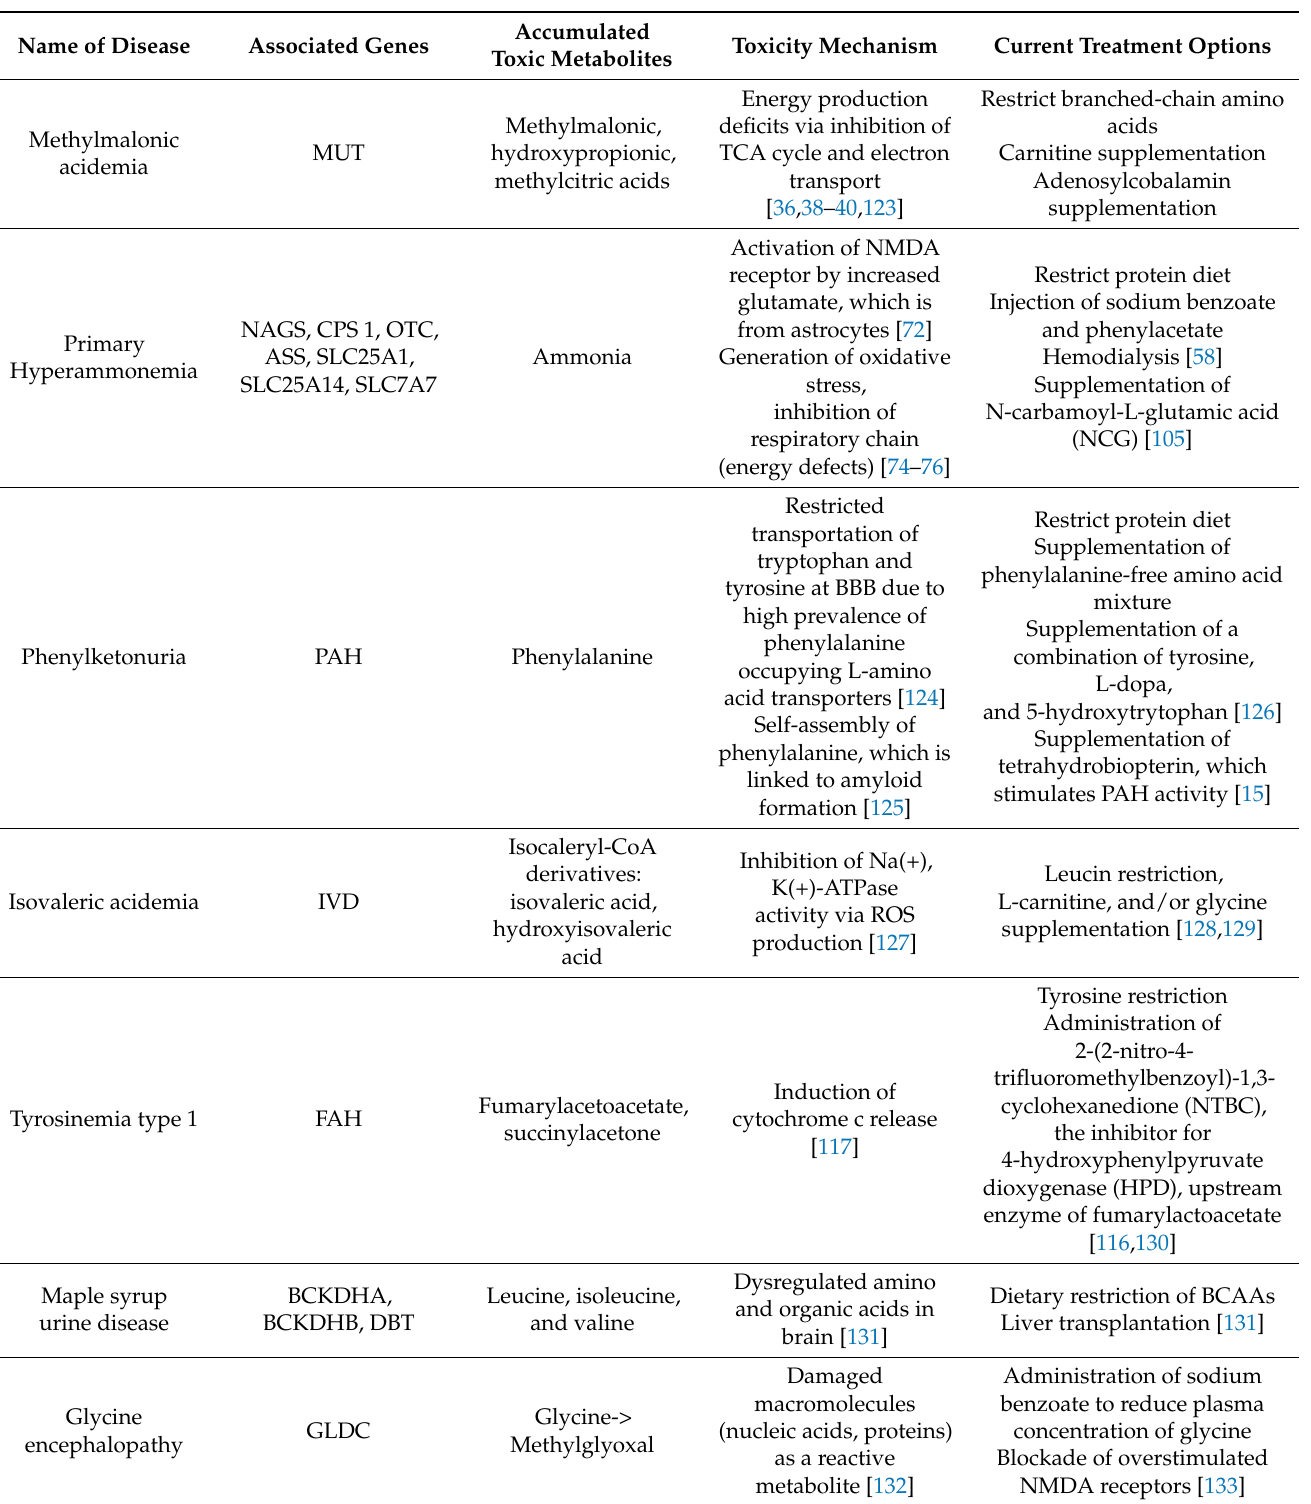
Table 1. List of IEMs caused by toxic metabolite accumulation and their toxicity mechanism and current treatment